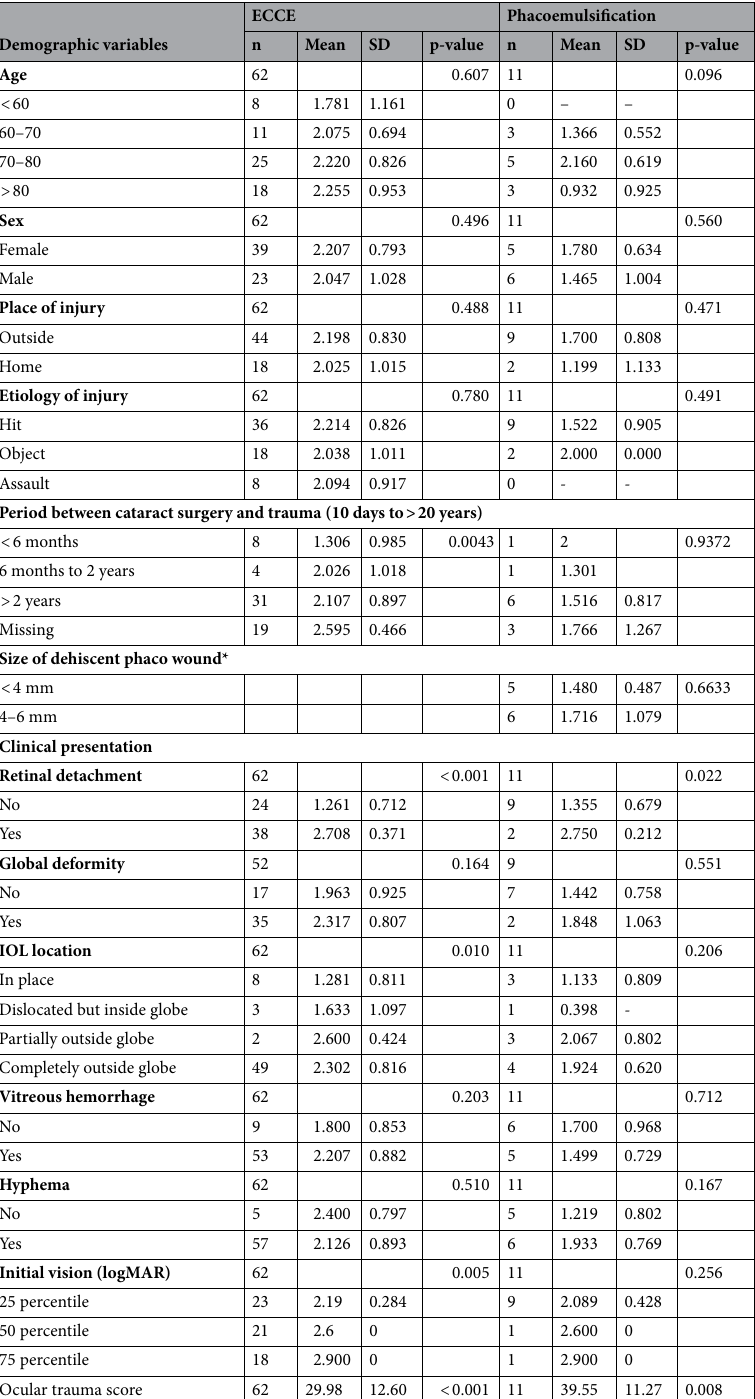
Table 4. Risk factors analysis for final visual outcome (logMAR) by extracapsular cataract extraction (ECCE) and phacoemulsification Patients followed for < 1 month are excluded. SD Standard deviation, IOL Intraocular lens. *The size of dehiscent wound with prior phacoemulsification recorded at emergency room or operation